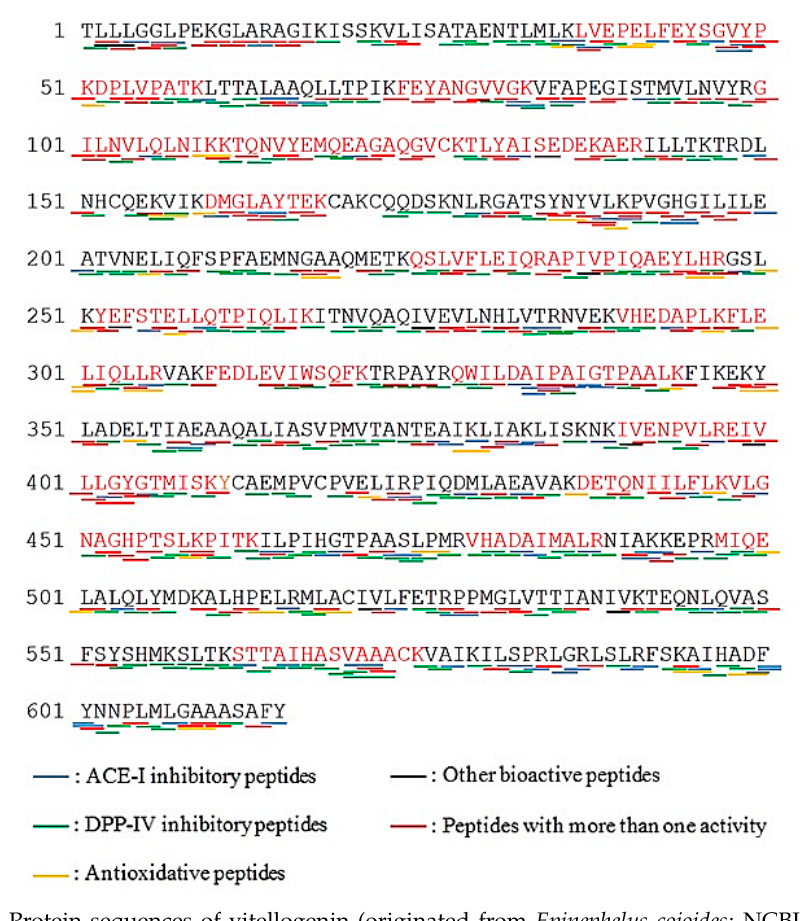
Numbers in parentheses represent the frequency of occurrence (A) of bioactive peptides rounded off to 3rd decimal place. * Other activities: antibacterial, immunomodulating, stimulating, neuropeptide, regulating, inhibitor, hypotensive, activating ubiquitin-mediated proteolysis.